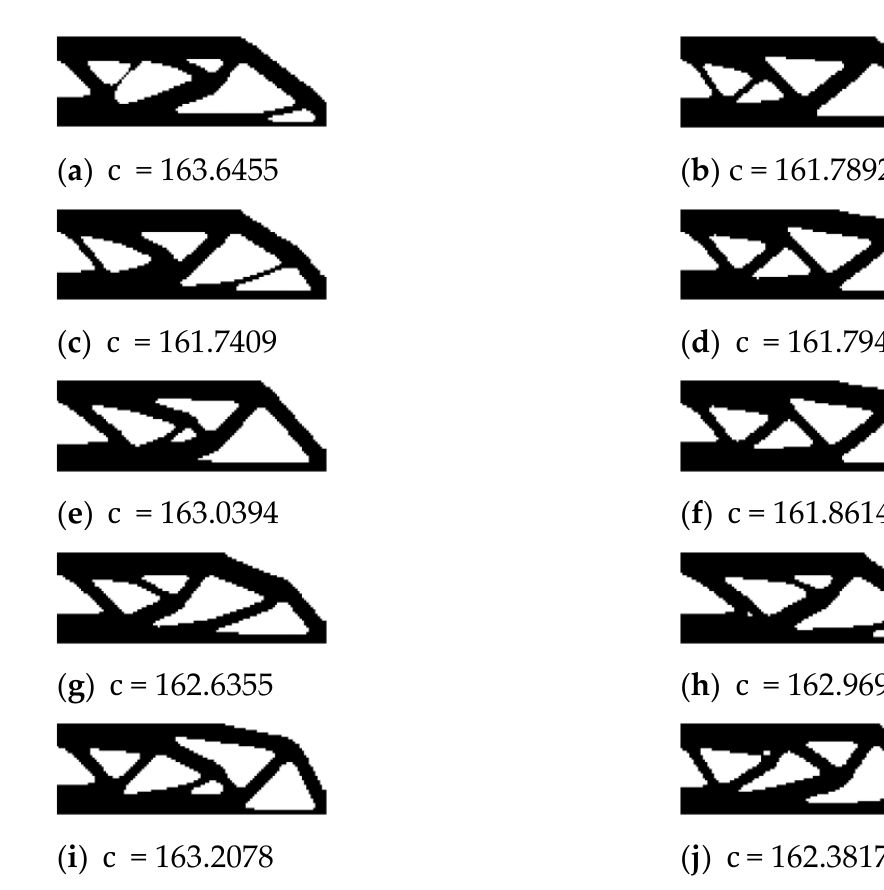
Figure 4. Variation of objective function with iteration steps. An MBB beam with a grid density of 120 × 40 was then selected for analysis. We set the filter radius and volume fraction to 3 and 0.6, respectively. After running the SIMP-GA method 10 times, we obtained the results shown in Figure 5.